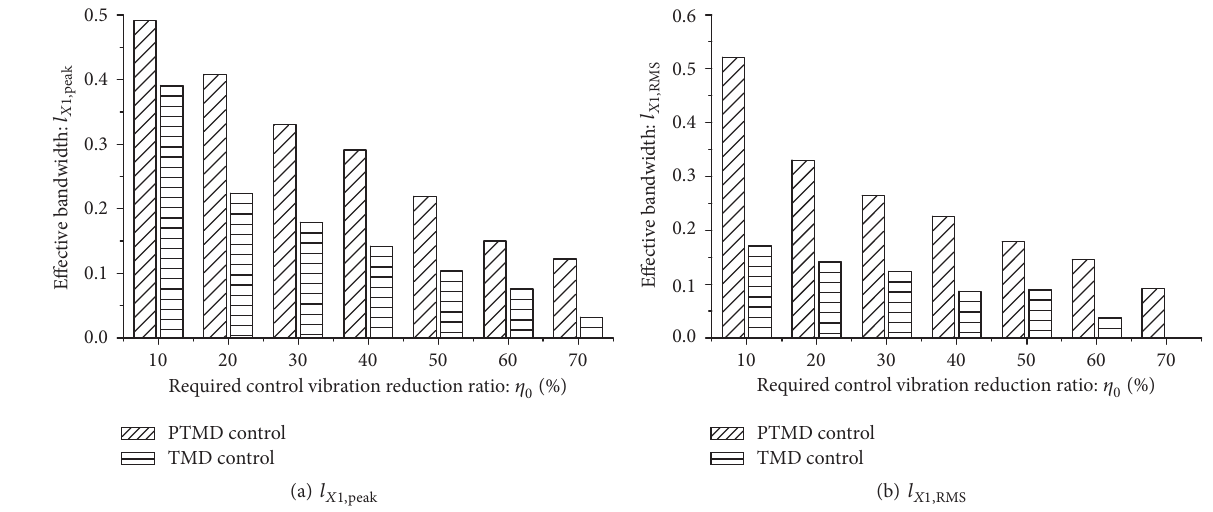
Figure 14: Comparison of effective bandwidth on dimensionless displacement.